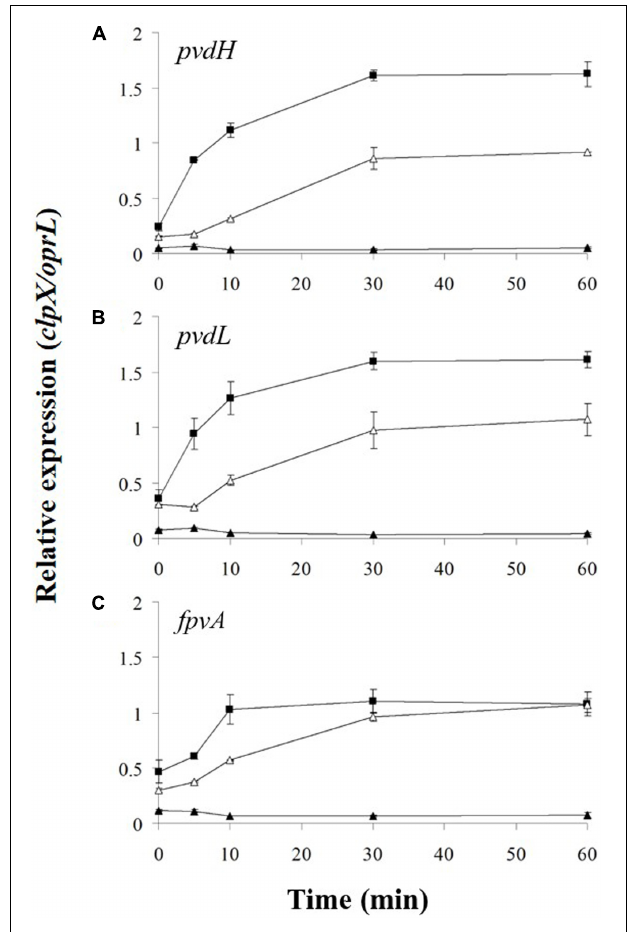
FIGURE 4 | Effect of clpP mutation on induction of gene expression. Pyoverdine was added (0 min) to P. aeruginosa PAO1 pvdF clpP (black triangles) and P. aeruginosa PAO1 pvdF clpP (minictx:: tig-clpP ) (open triangles). Samples were collected at intervals and analyzed by RT-qPCR. Data are means of six technical replicates with standard deviation shown. Equivalent data from strain PAO1 pvdF bacteria ( Figure 2 ) (black squares) are included for comparison. (A) pvdH . (B) pvdL . (C) fpvA